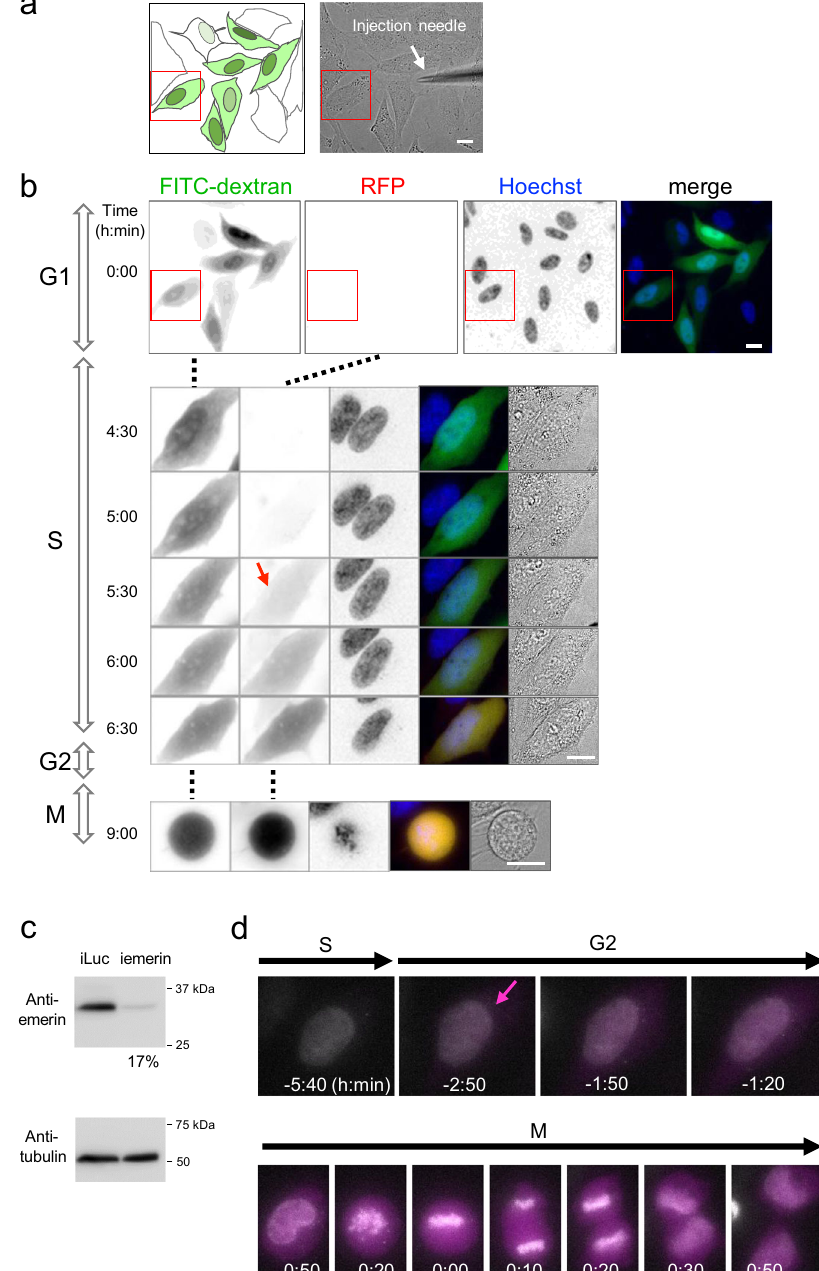
Fig. 6 NE rupture causes premitotic gene expression. a HeLa cells were transfected with pEF1 α -RFP plasmid. NE was ruptured with a microinjection needle by microinjecting FITC-dextran into the nucleus. Left, schematics of microinjected cells (shaded in green) in upper left panel in b . Regions colored in dark green represent the position of the nucleus with higher FITC-dextran signals. Right, bright- fi eld image of the same cells as in b . An arrow indicates a microinjection needle used for microinjection into the nucleus to achieve NE rupture. Bar, 10 μ m. b Time-lapse images of the microinjected cells shown in a . Immediately after microinjection (NE rupture), time-lapse images were acquired every 10 min (2 μ m × 5 z -stacks for each time point). Images projected by the maximum intensity projection for z -stacks are shown. The cell in the red-boxed region in the top panel (time 0:00) is shown in the lower panels (time 4:30 – 9:00). From left to right, FITC-dextran, RFP, and Hoechst, merged, bright- fi eld images. Colors in merged images, FITC-dextran (green), RFP (red), and Hoechst 33342 (blue). The numbers represent time (h:min) from the start of imaging. Red arrow indicates the start of RFP expression. G1, S, G2, M represent the cell-cycle phases. Bars, 10 μ m. c Western blotting of HeLa cells treated with siRNA targeting EMD (iemerin) and the control (iLuc), showing that emerin expression in the cells treated with siRNA was reduced to 17% of control levels. d Time-lapse images of the cells treated with iemerin. HeLa cells were treated with siRNA targeting EMD (iemerin). The cells were transfected with pEF1 α -RFP plasmid. DNA was stained with Hoechst 33342 (white). Time-lapse images were collected every 10 min (2 μ m × 5 z -stacks for each time point) after transfection. Images projected by the maximum intensity projection for z -stacks are shown. Time 0 represents the onset of chromosome segregation. RFP expression (magenta) from transfected plasmid appeared in premitotic stage. Magenta arrow indicates the start of RFP expression. S, G2, and M represent the S, G2, and M phases of the cell cycle. Bar, 10 μ m.